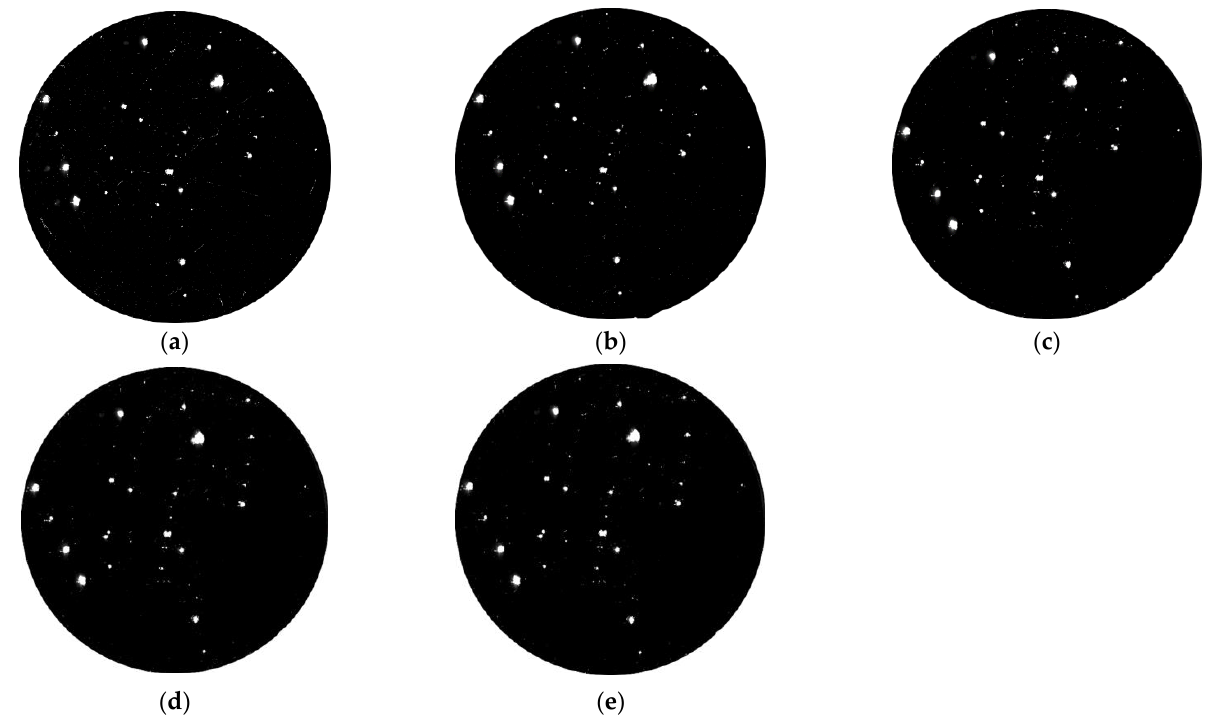
Figure 6. Laser scattering results after MRF process: ( a ) Material removal depth 0 μm; ( b ) Material removal depth 1.5 μm; ( c ) Material removal depth 3 μm; ( d ) Material removal depth 4.5 μm; ( e ) Material removal depth 6 μm. Table 3. Defects number with different removal depths.